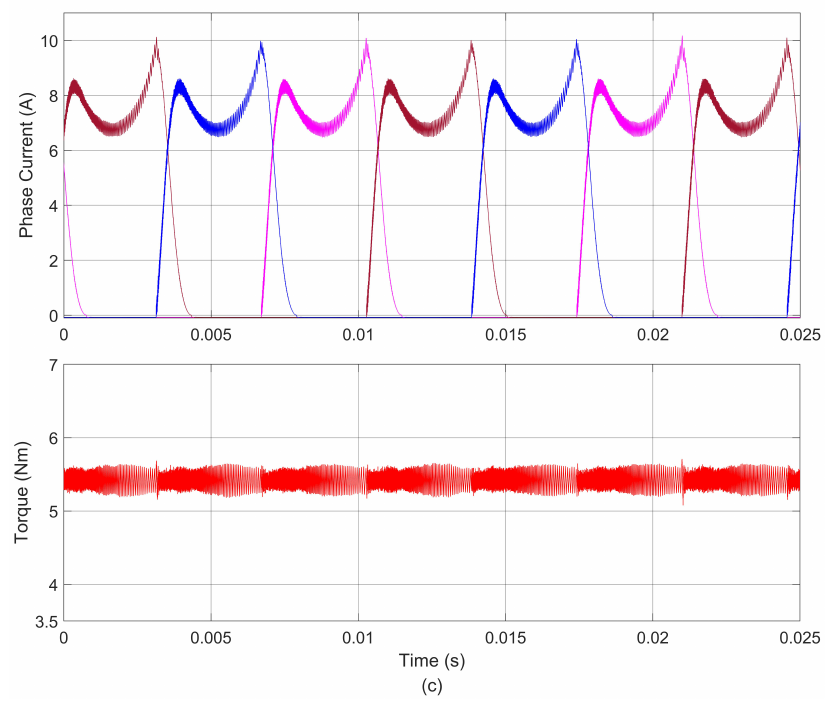
Figure 11. Phase current and electromagnetic torque at 5 Nm, 700 rpm with ( a ) fuzzy compensator,